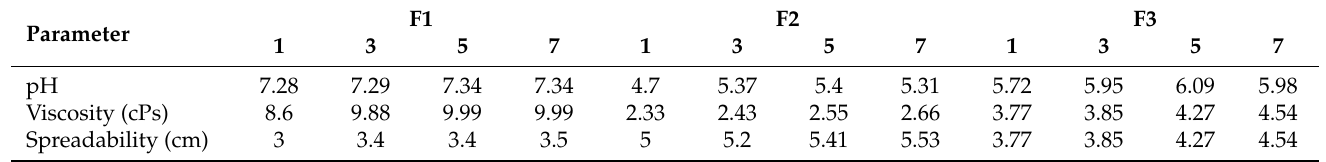
Table 1. Physical stability of the optimized formula during storage (7